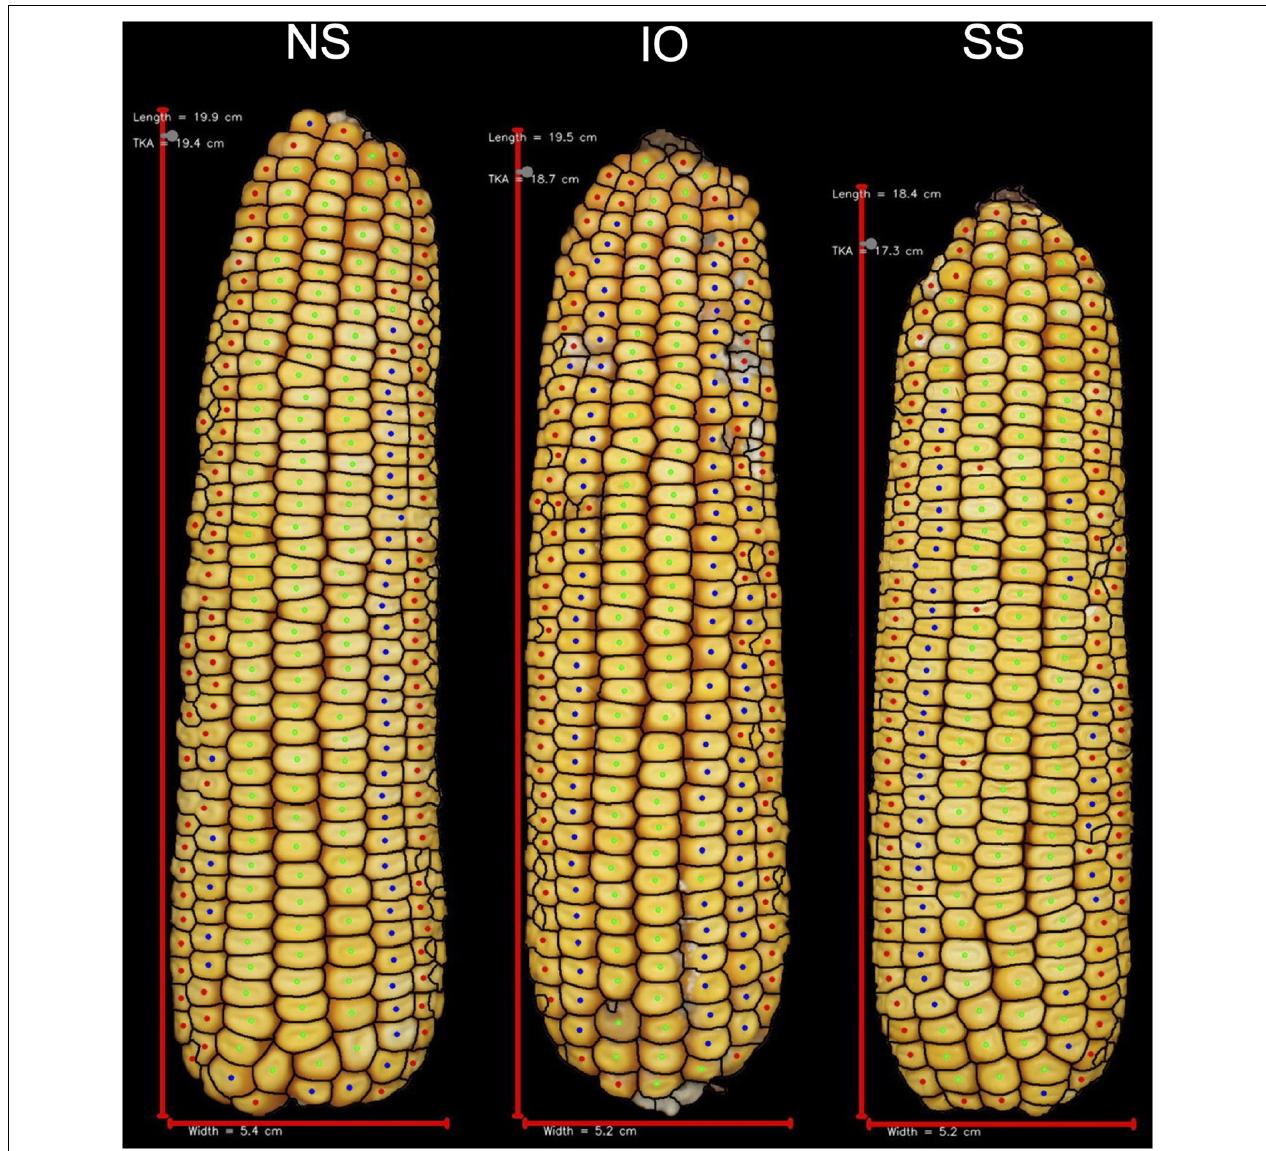
FIGURE 4 | Representative ears for each of the heterotic groups in hybrid combination with 2FACC. Selected ears had an average yield and yield components for their heterotic group combination. Abbreviations for heterotic groups include: NS (Non-Stiff Stalk), IO (Iodent), and SS (Stiff